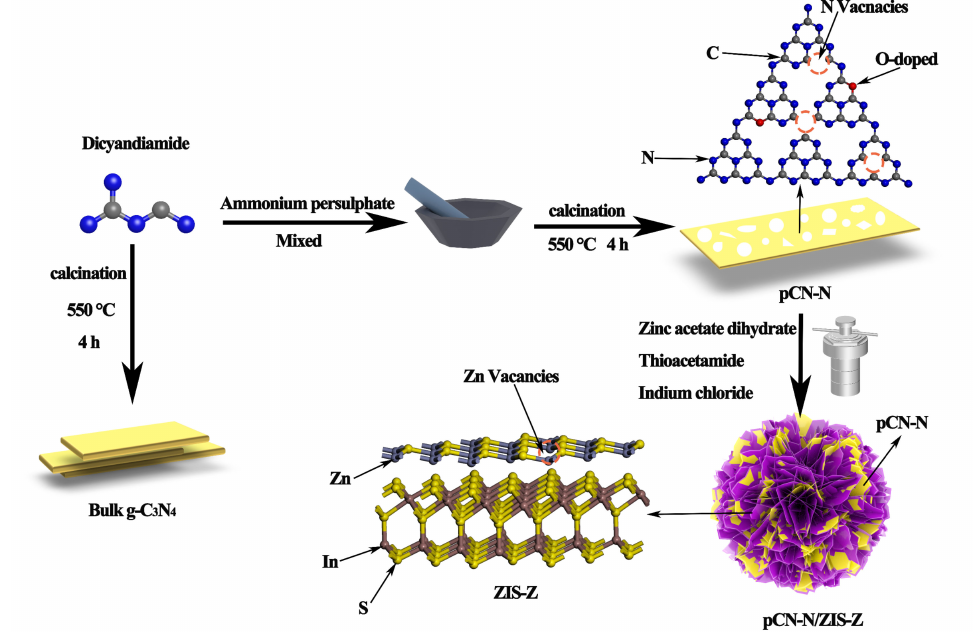
Figure 1. The synthesis process of CN, pCN-N, ZIS-Z,